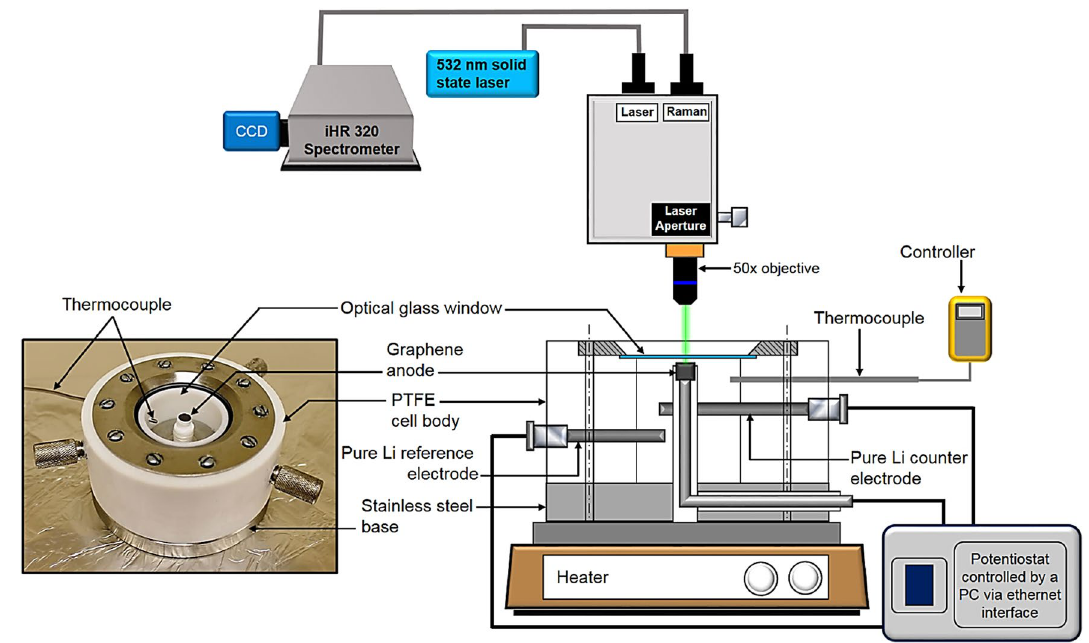
Fig. 2 Schematic representation of the experimental setup used for in situ Raman spectroscopy of surface changes in graphene nanoflake-based anodes cycled in an electrochemical cell with glass window at elevated